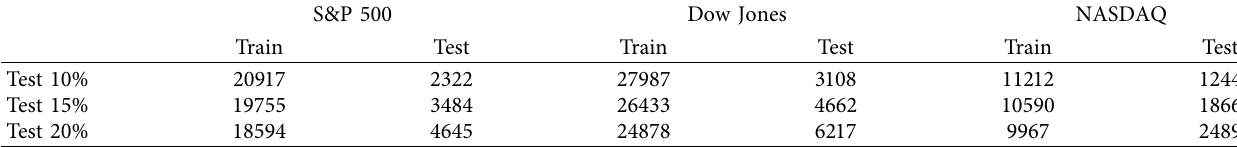
Table 6: Length of the train set and test set in trading days under different train-test sample splits.